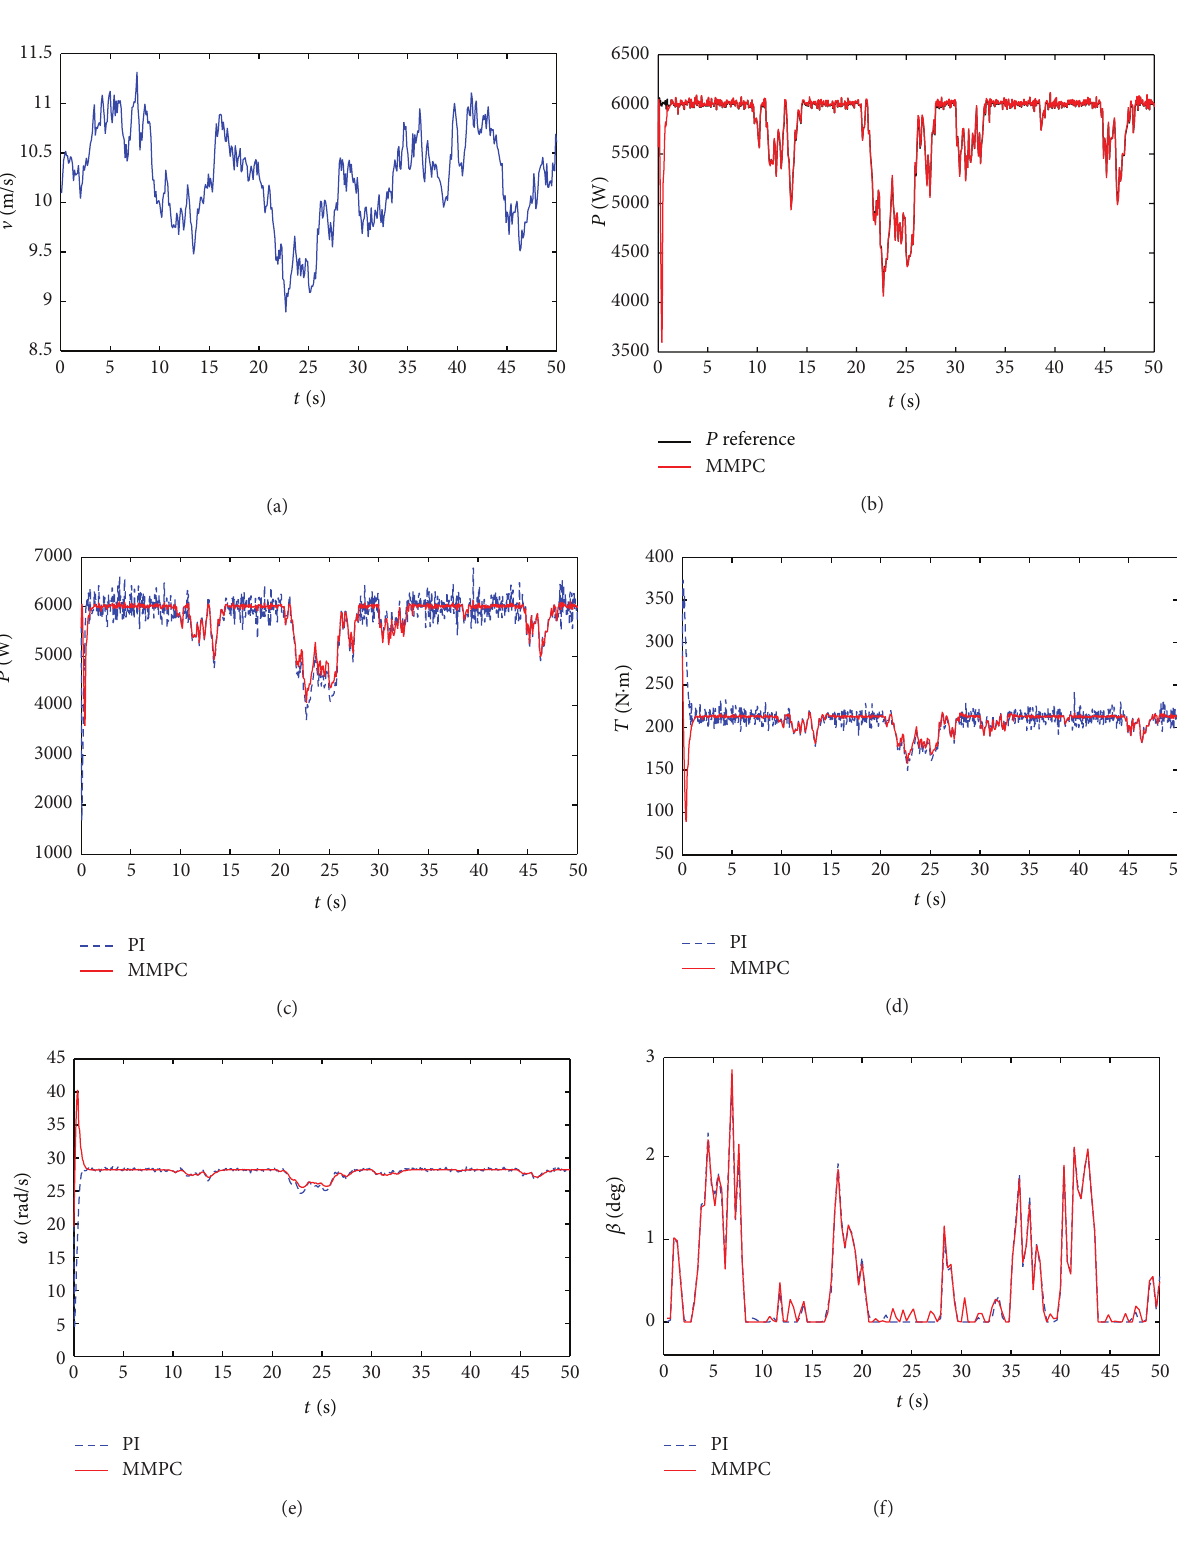
Figure 8: (a) Wind speed. (b) Generator power. (c) Generator power. (d) Generator torque. (e) Turbine rotational speed. (f) Pitch